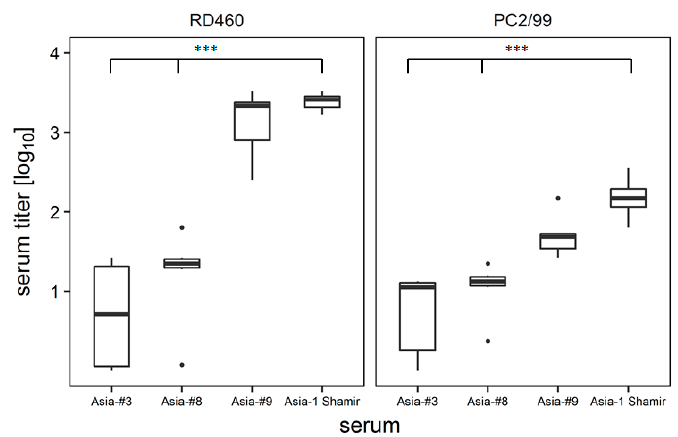
Figure 7. Serum neutralization tests revealed an altered neutralization profile of the adapted viruses. Asia-1 Shamir and the adapted Asia-1 isolates #3, #8 and #9 were incubated with serum from experimentally infected (“RD460”) or vaccinated (“PC2/99”) cattle. Experiments were performed in duplicates and repeated for a total of three times. Significance code: *** p < 0.001.